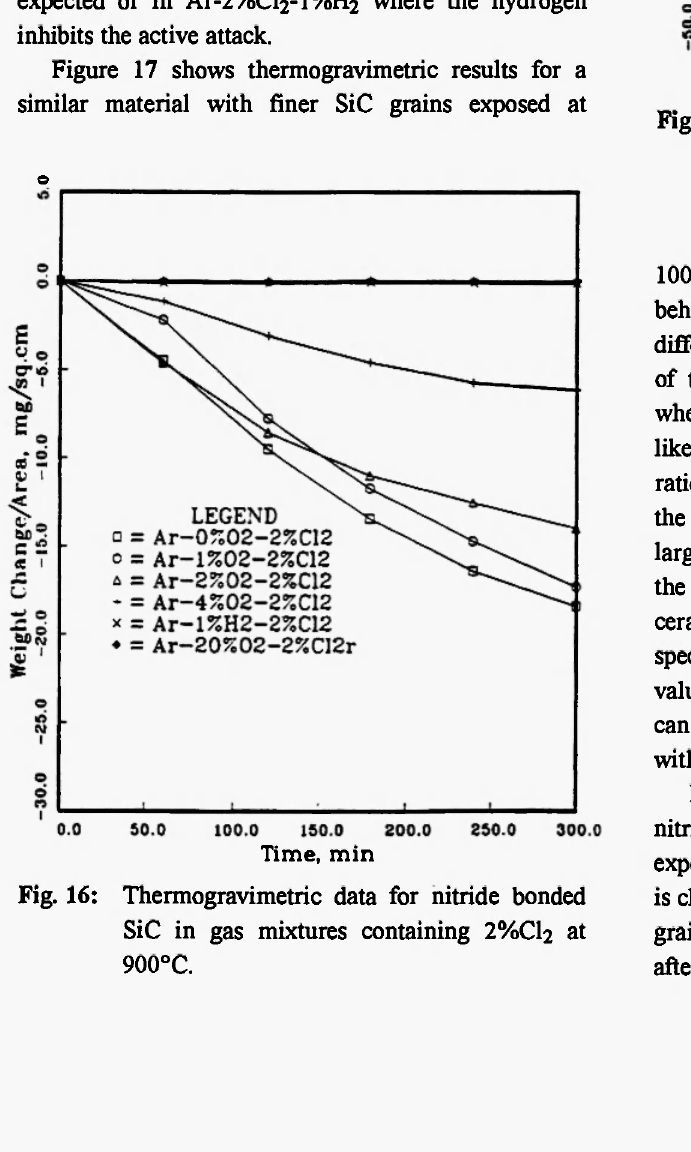
Fig. 17: Thermogravimetric data for nitride bonded SiC with fine SiC particle size in gas mixtures containing 2%C1 at 2